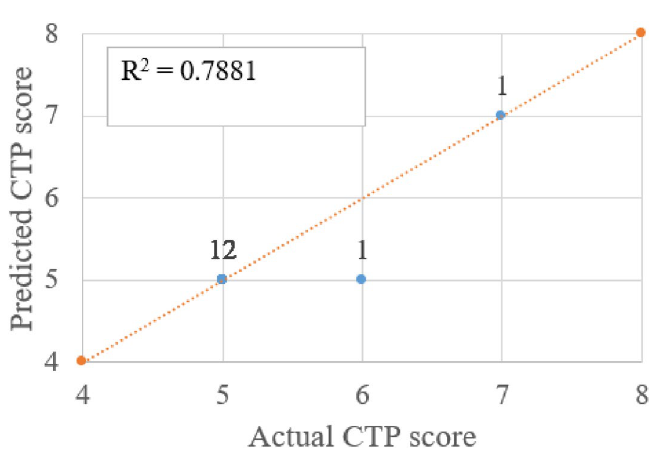
Figure 10. Comparison of actual and predicted CTP score (using ETR) and number of instances shown as label.